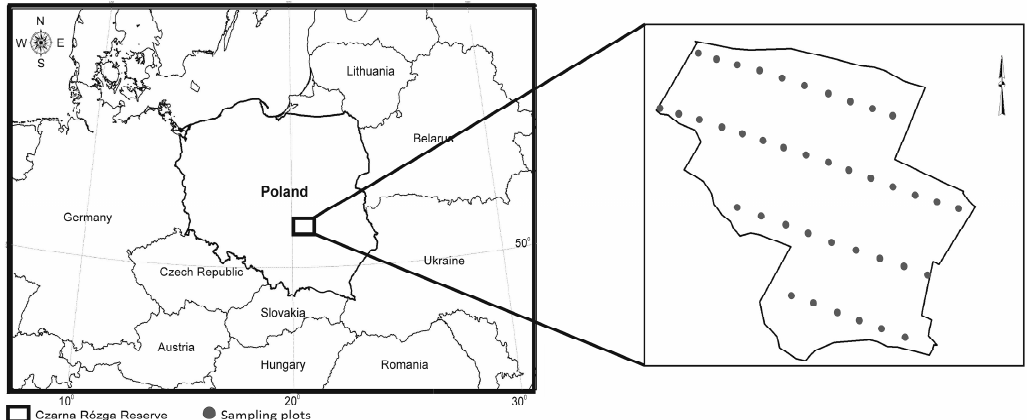
Figure 1. Study sites location (Czarna Rózga Reserve in Central Poland).